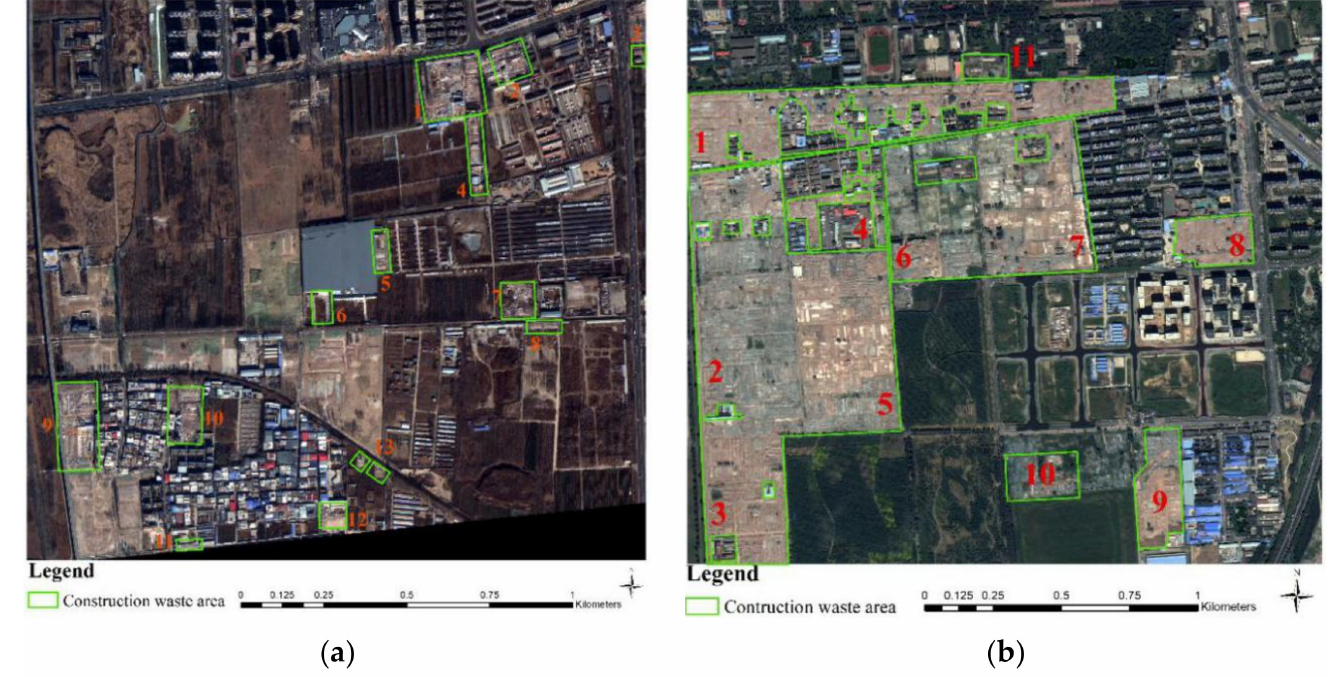
Figure 2. The reference data for the construction waste. ( a ) Case A (13 points); ( b ) Case B (11